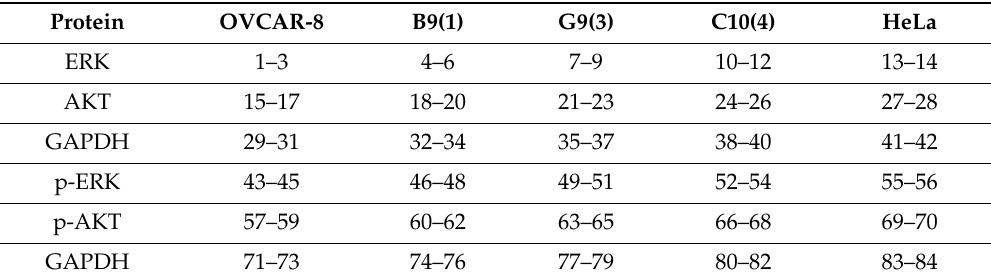
Table 1. Samples analyzed in the generated clones